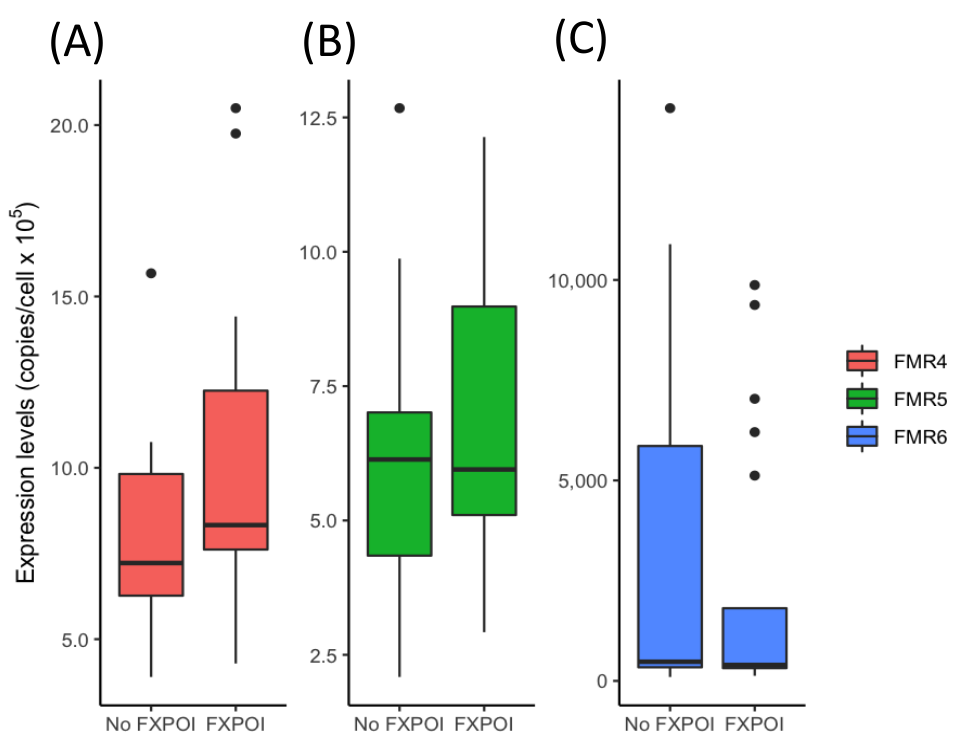
Figure 1. Expression levels of FMR4, FMR5 and FMR6 were compared between FMR1 premutation carriers with FXPOI and without FXPOI. ( A ) The expression level of FMR4, ( B ) The expression level of FMR5 and ( C ) The expression level of FMR6. None of the comparisons were statistically significant ( p > 0.05). Table 2. Distribution of FMR1 premutation carriers with and without FXPOI based on FMR4, FMR5 and FMR6 expression levels.